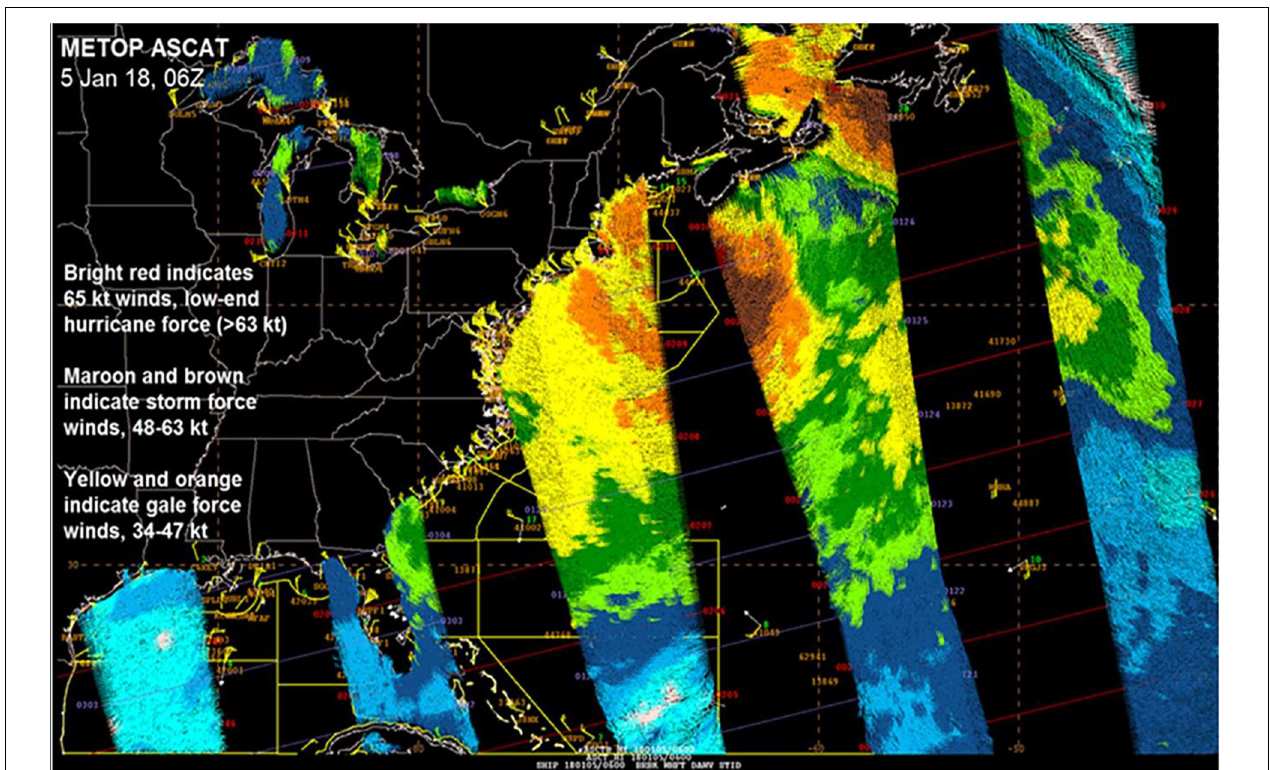
FIGURE 2 | EUMETSAT MetOp Advanced Scatterometer data (colored swaths), with available ship observations (using standard synoptic station notation), from 0600 UTC on January 5, 2018. Courtesy of National Oceanic and Atmospheric Administration, NWS, Ocean Prediction